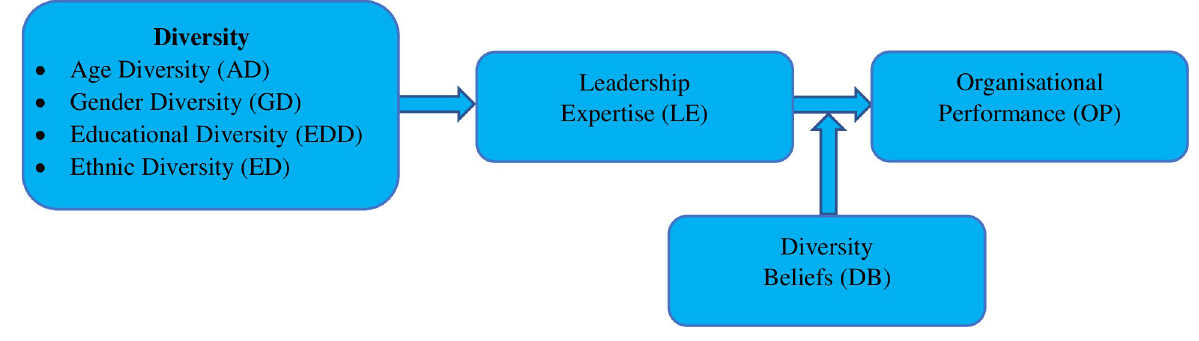
Fig 1. Conceptual